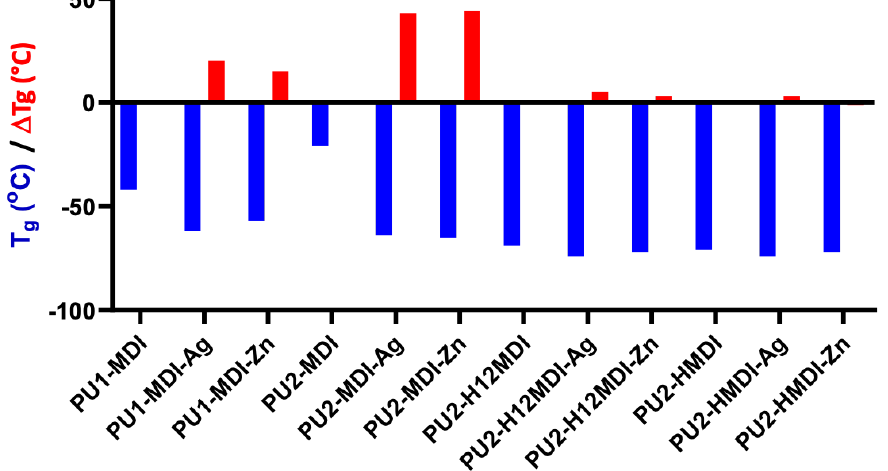
Figure 8. Glass transition temperature (T g ) of polymers and decrease in T g (red bars), ∆ T g = T gPU — T gPU/metal , after polymer neutralization with either silver or zinc.